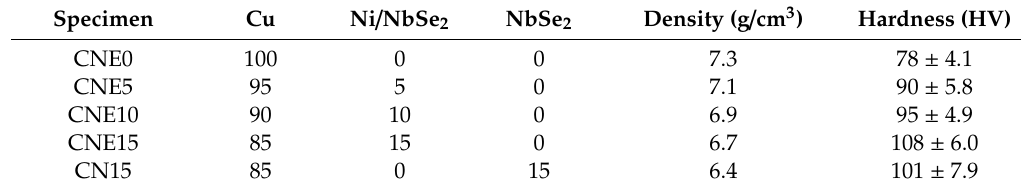
Table 2. Density and hardness of Cu / Ni / NbSe 2 composites (mass fraction / wt.%).